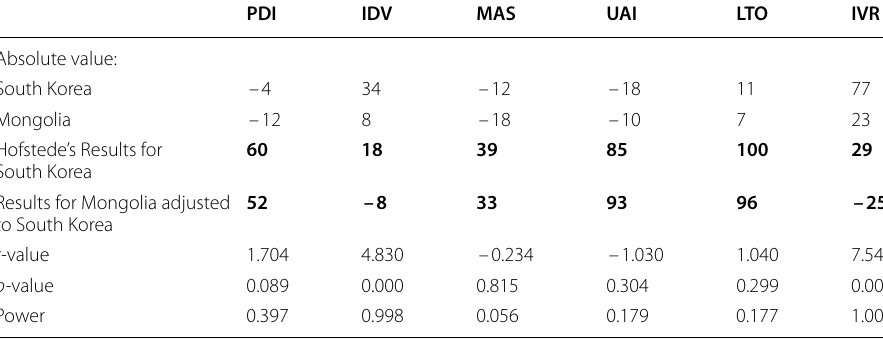
Table 4 Independent samples t -test results for PCS